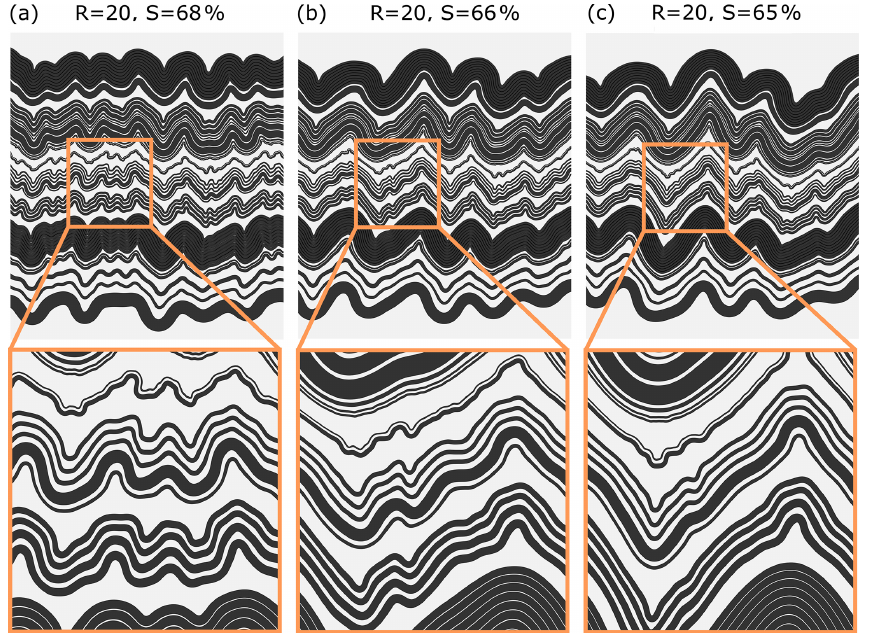
Figure 16. (a–c) Models showing the role of the thickness of the bounding layers for H out /h ref = 75, 150, and 300, respectively. In all models, the viscosity ratio between the dark and white layers is set to R =